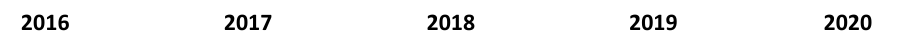
Figure 3. Time series of root-zone soil moisture (cm 3 ·cm − 3 ) from 2016 to 2020 at the ( a ) Shebotu site, ( b ) Huolinguole site and ( c ) Wengniute site. Red solid lines indicate root-zone soil moisture meas- urements at in-situ stations, and blue dotted lines indicate root-zone soil moisture predictions from the calibrated SMAR model at the point scale, where the ESA CCI near-surface soil moisture data are used for model forcing.